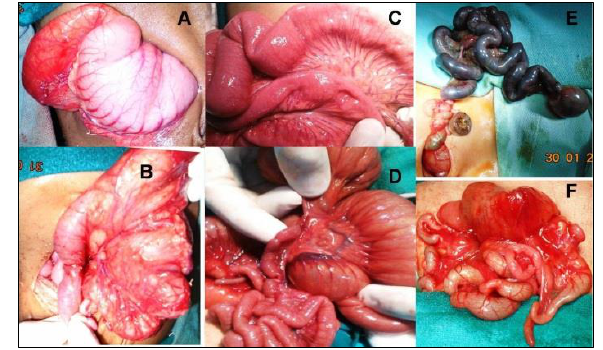
Figure 3: Intra-operative images showing dilated stomach and proximal duodenum (A), with perforated duodenal web (B); ileal web (C); jejunal atresia type II (D), jejuno-ileal atresia type IIIb (E); type IV jejuno-ileal atresia